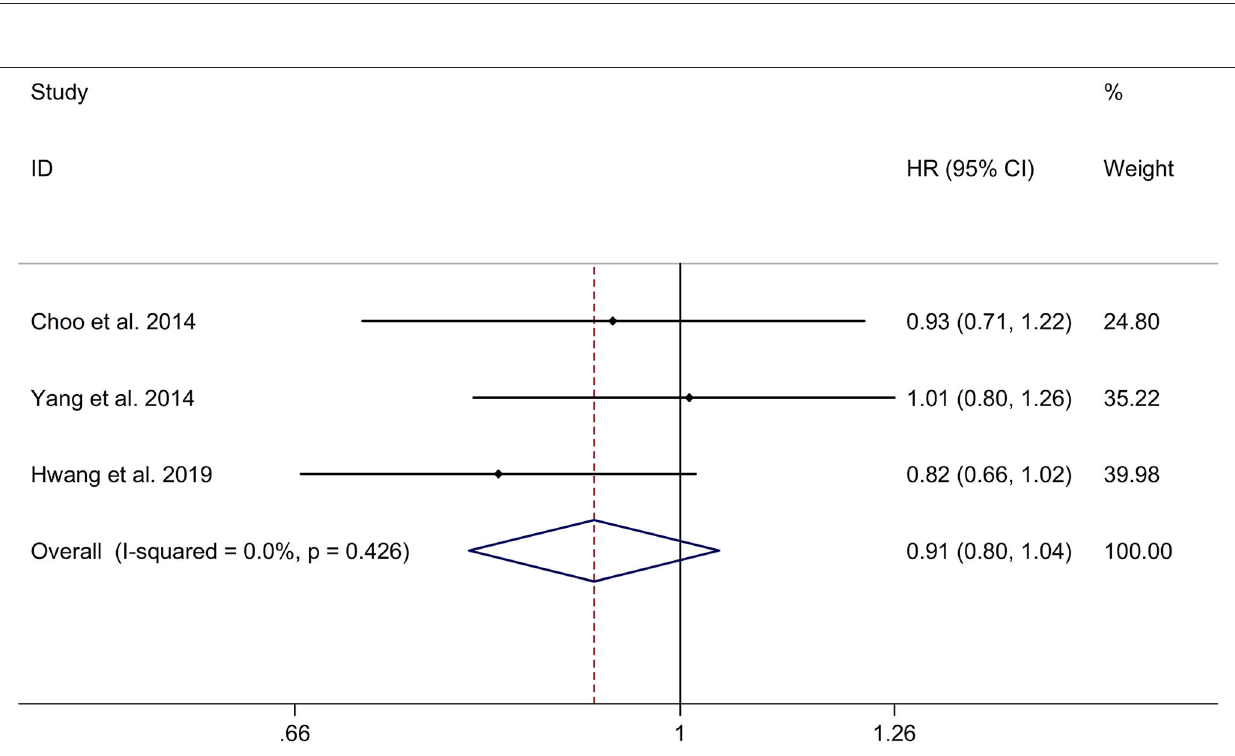
Frontiers in Cardiovascular Medicine |